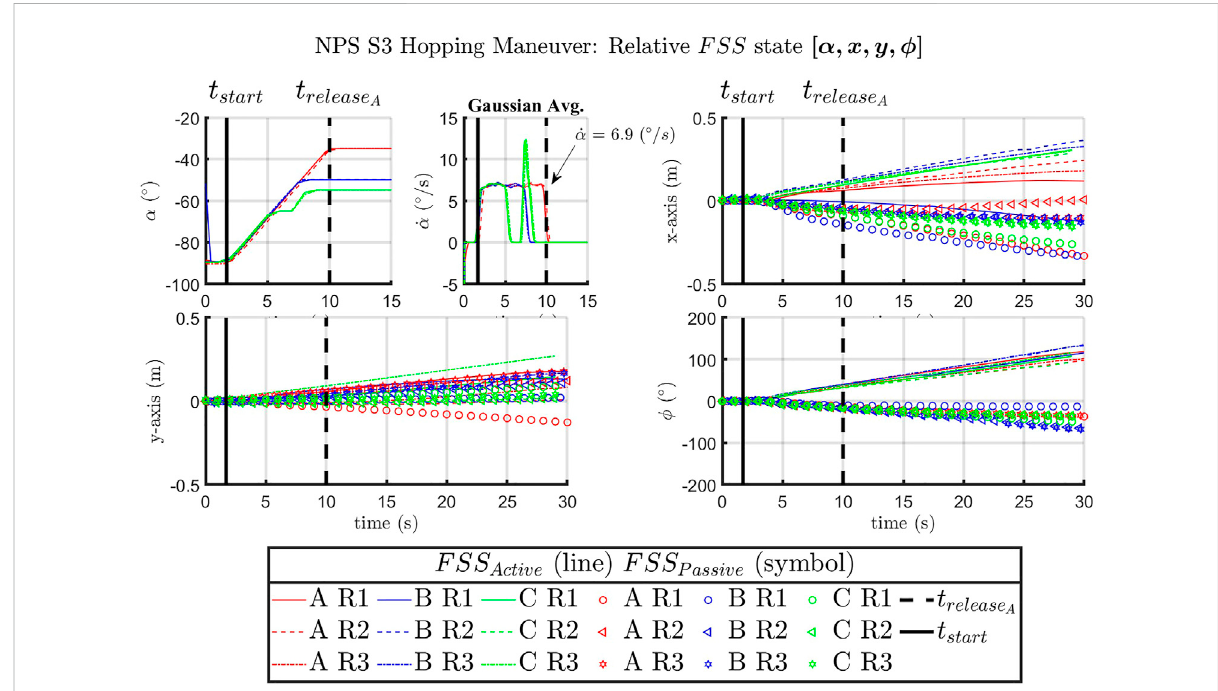
FIGURE 6 SRL [ α , x , y , ϕ ] for the FSS Active vehicle over time. Time markers indicate t start of proximal joint actuation and t release A for case A.